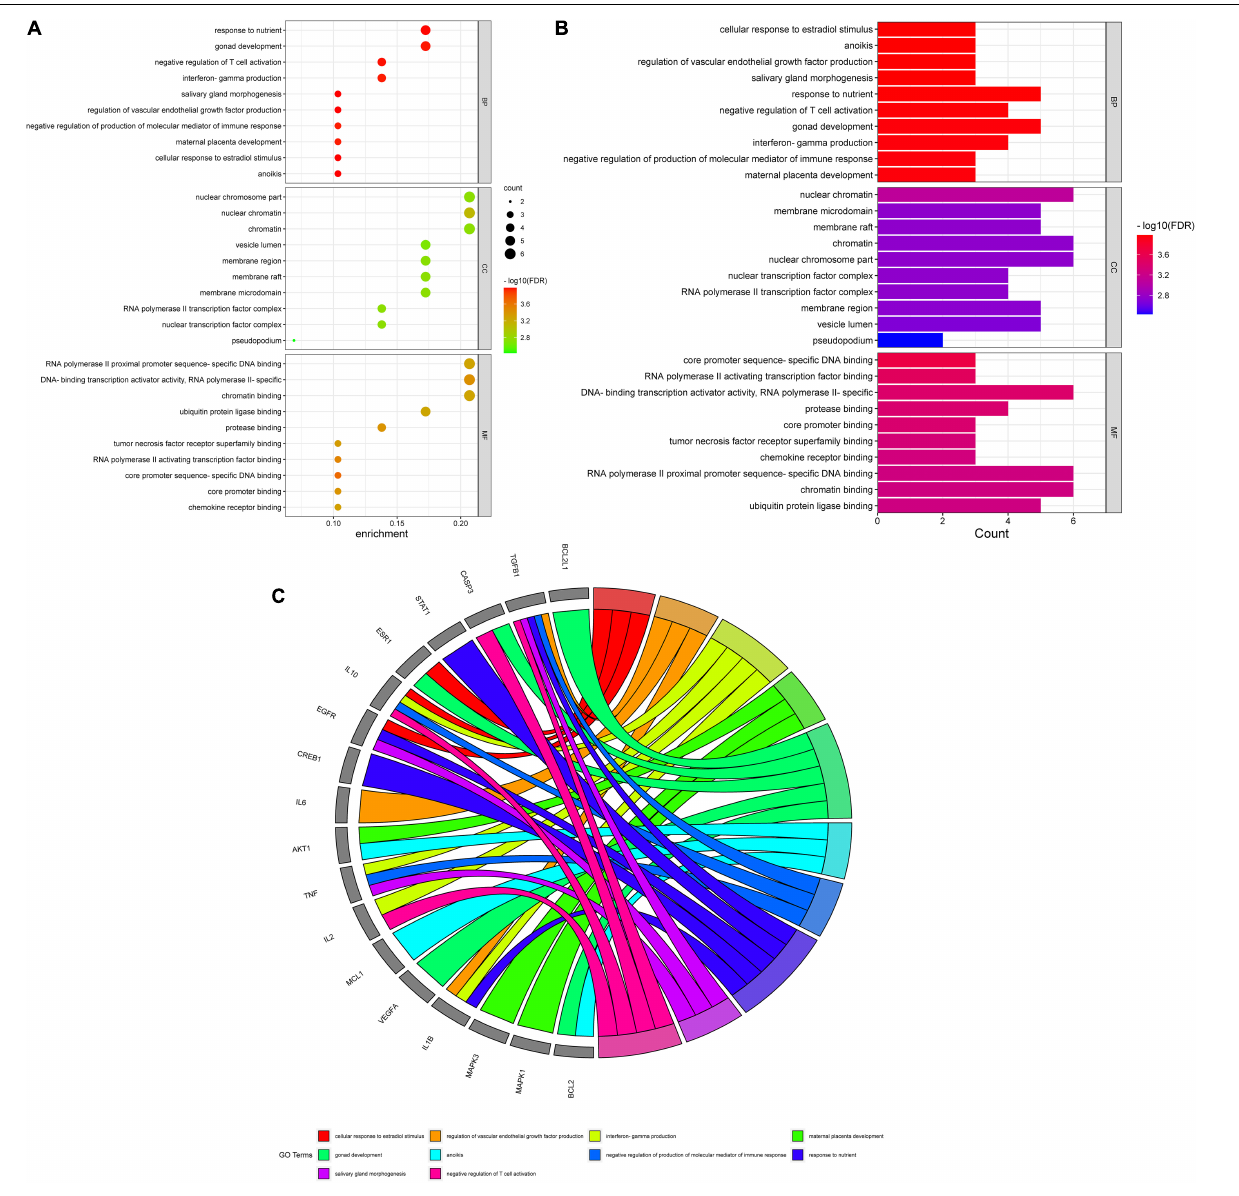
FIGURE 4 | Kyoto Encyclopedia of Genes and Genomes enrichment assay data in VA against As-linked dermatitis, as uncovered in bubble (A) , bar (B) , and circle (C) charts.